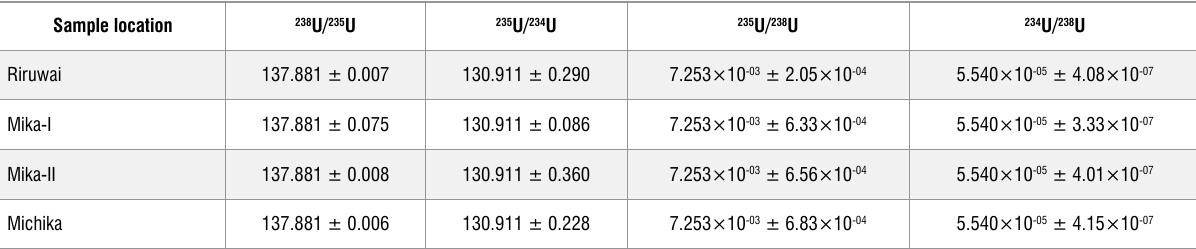
Table 3: Uranium concentration isotopic ratios of the natural uranium samples Sample